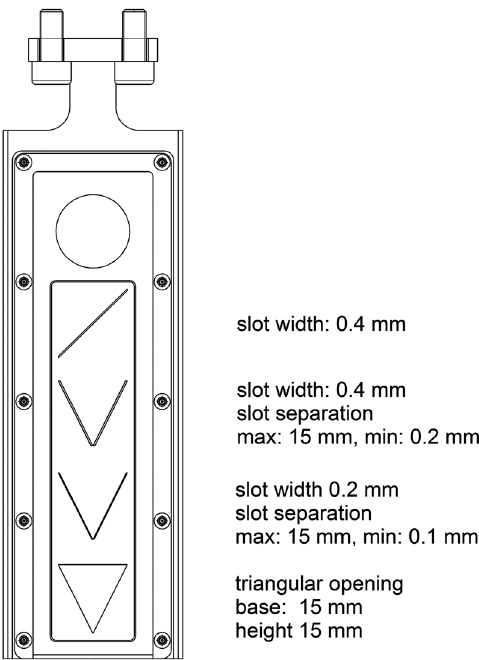
FIG. 4. Design of the aluminum slotted foil planned for